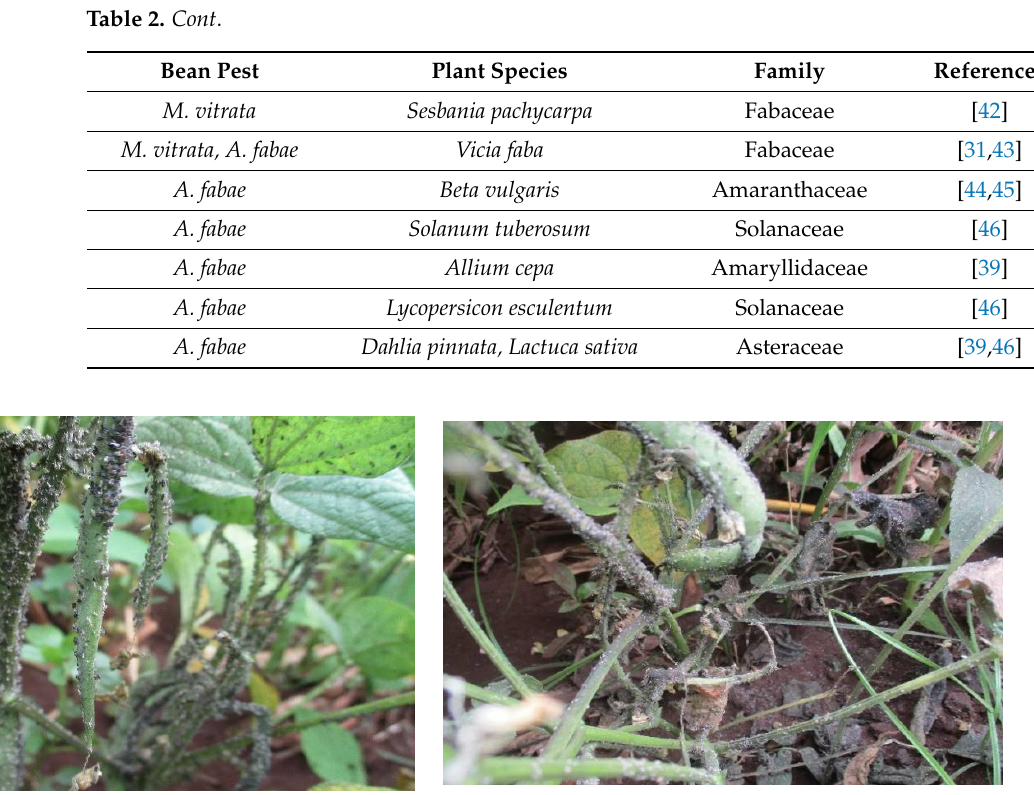
Figure 2. Aphis fabae infestation in beans (Photograph by Baltazar Ndakidemi, NM-AIST-Arusha, Tanzania). Table 2. Host plant species for Maruca vitrata and Aphis fabae .